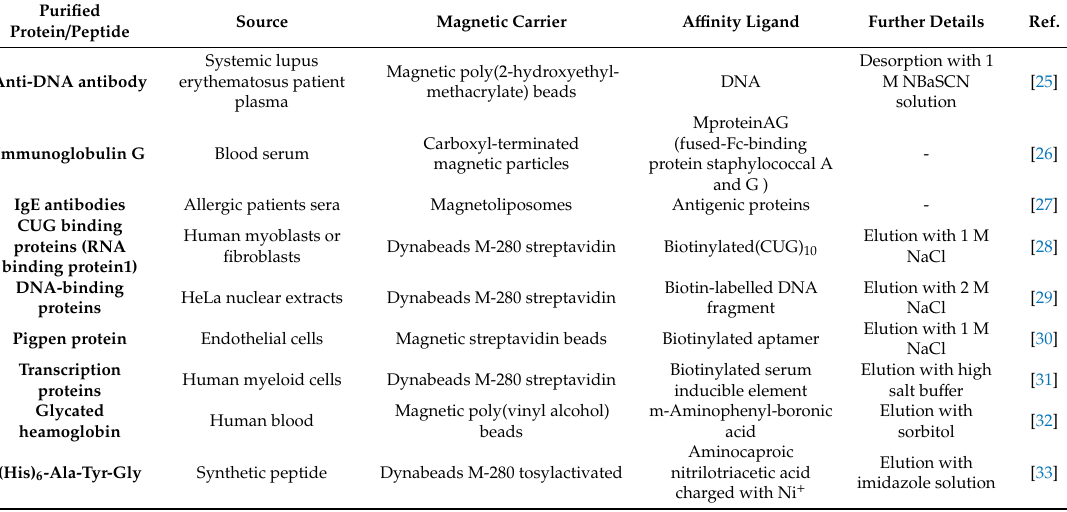
Table 1. Examples of proteins / peptides purified by magnetic